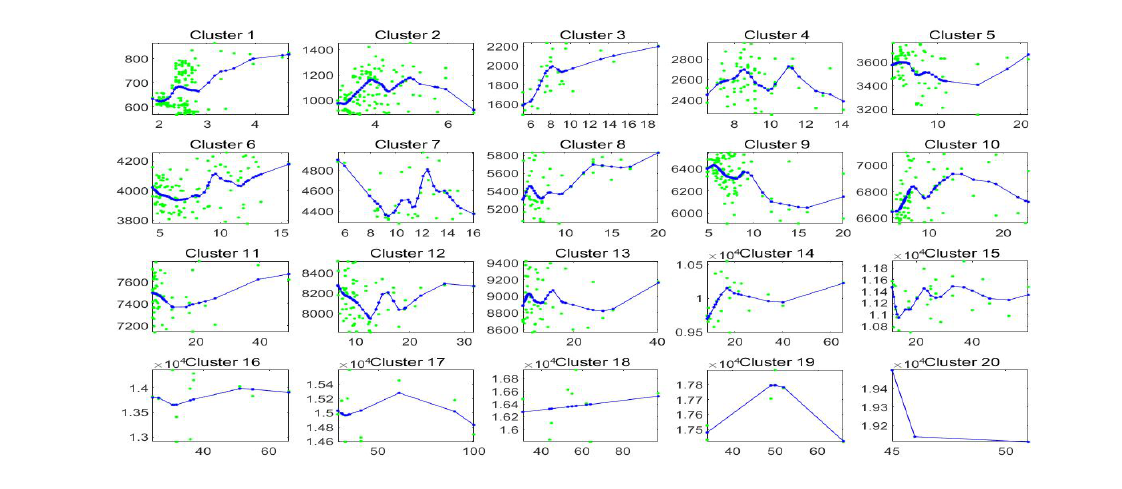
Figure 9. Clustering A: for each cluster, the fitted BitCoin subseries (blue colour) are obtained from L 2 -norm iF-transform function applied to the subset of data assigned to each cluster; the observed ( GT 100 t , BitCoin t ) values are